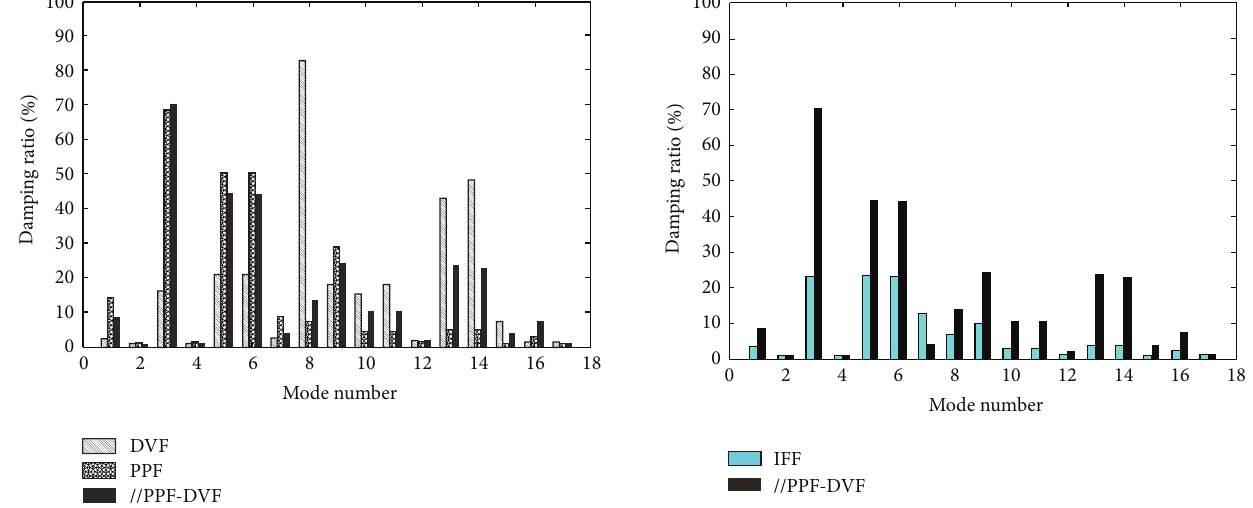
Figure 7: Maximum damping ratio as a function of mode number for IFF and parallel PPF-DVF concepts.